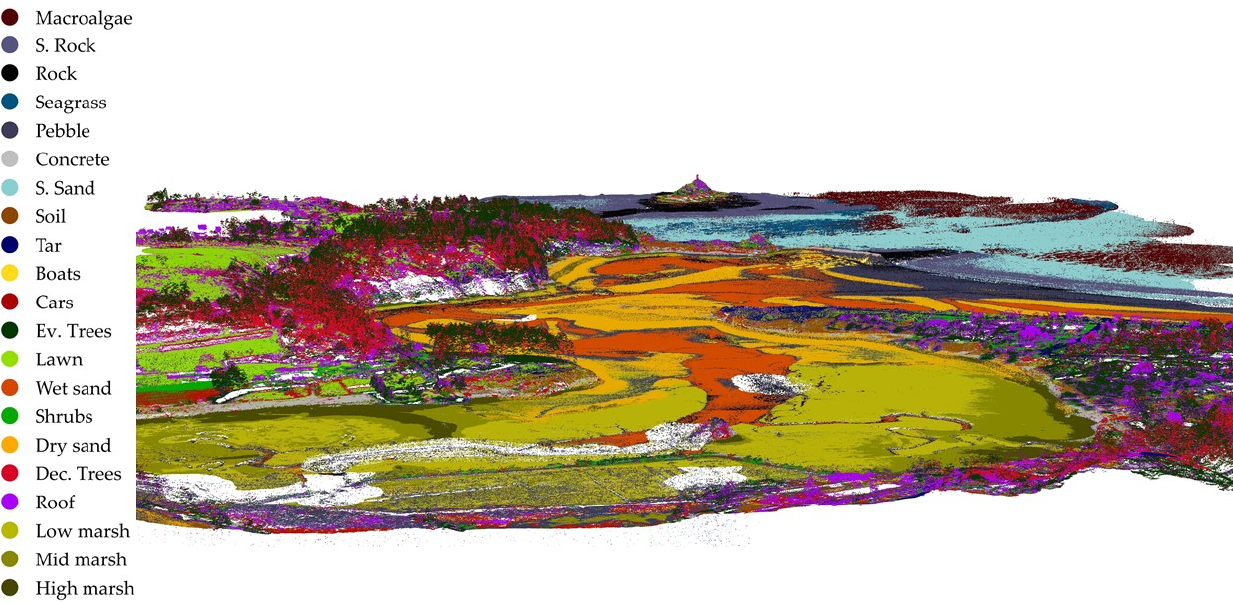
Figure 14. 3D map of the habitats obtained over the complete study area by the random forest classifier trained on green waveform features, infrared intensities, and elevations. S. = submerged, Ev. = evergreen, Dec. =